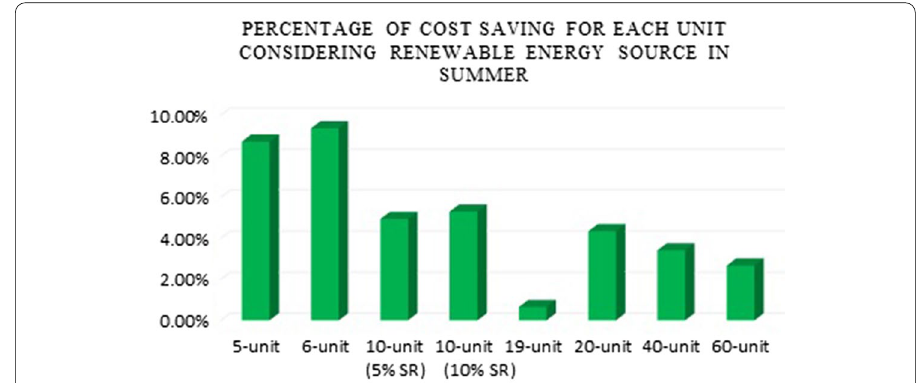
Fig. 13 Percentage of cost saving for each unit considering renewable energy source in winter using hHHO-SCA optimization